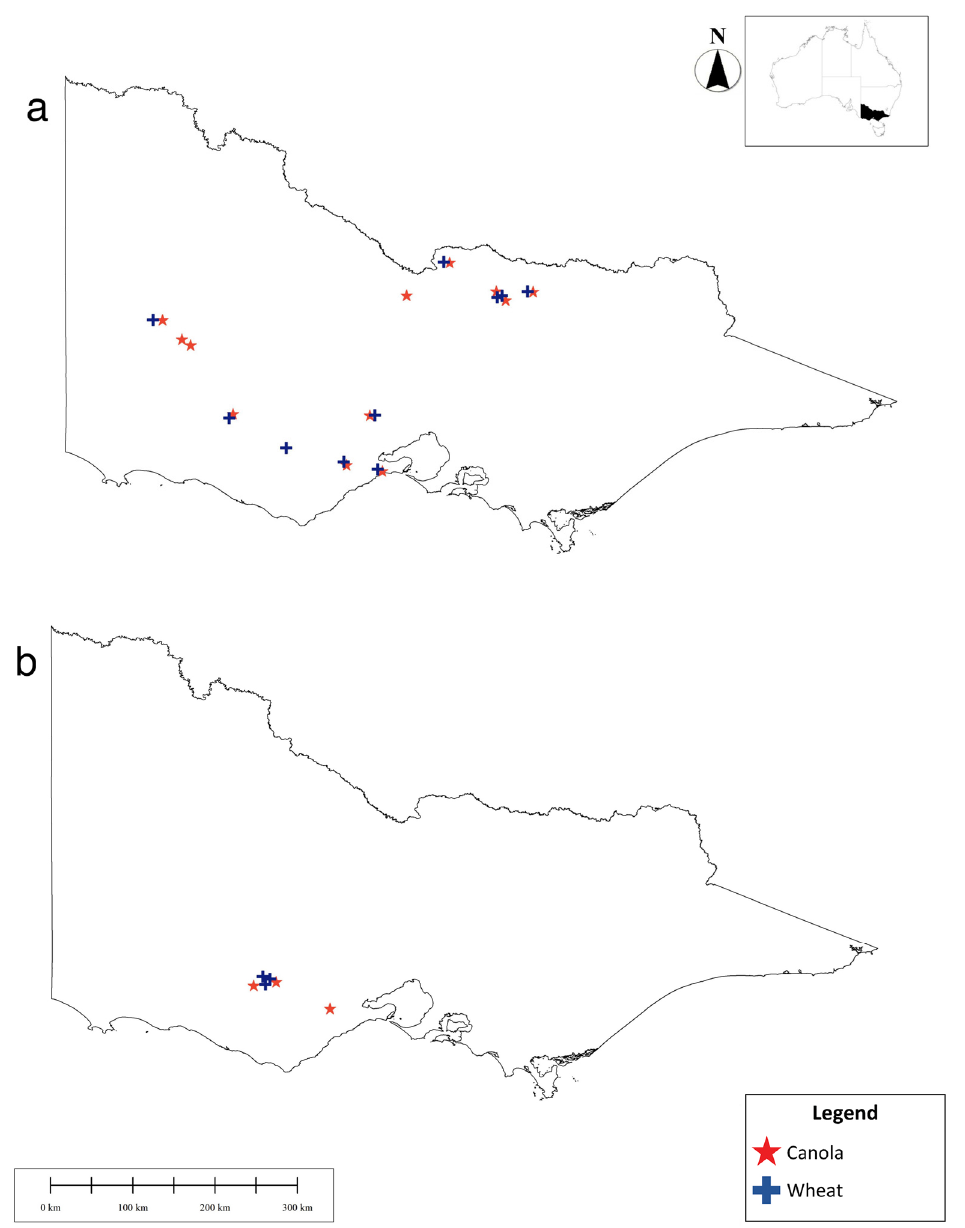
Figure 1. Location of ( a ) 2017 and ( b ) 2018 field sites, sorted into crop types (inset map depicts the state of Victoria at a national level) [32,33]. Map created in GlobalMapper